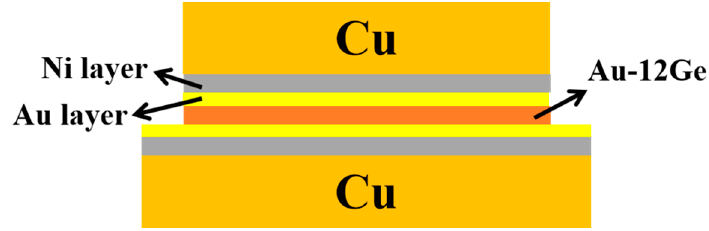
Figure 2. The schematic diagram of Cu/Ni/Au/Au-12Ge/Au/Ni/Cu joint.